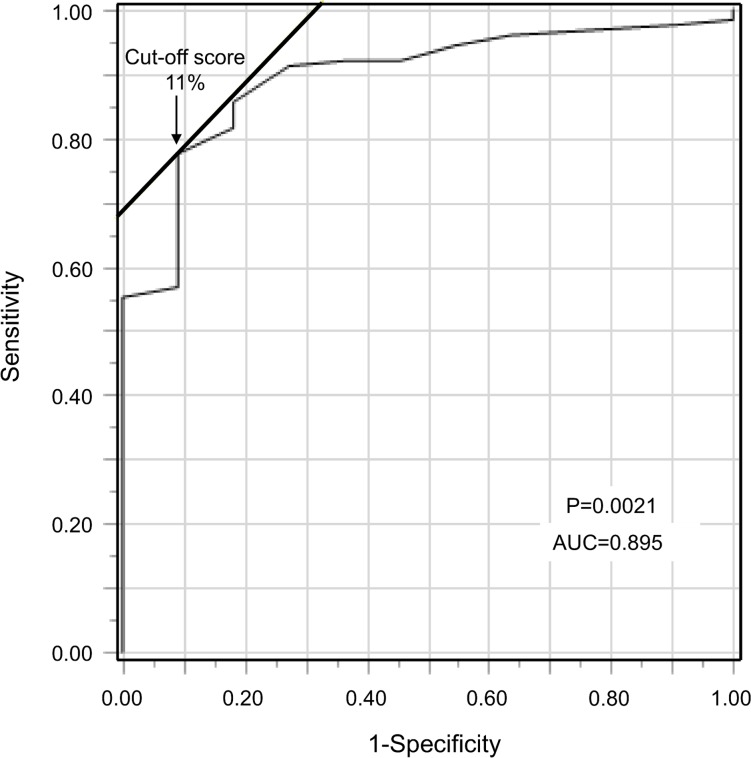
Receiver operating characteristic curve.The cut-off value for determining TACC3 positivity was 11% according to the Youden index. AUC: area under the curve.